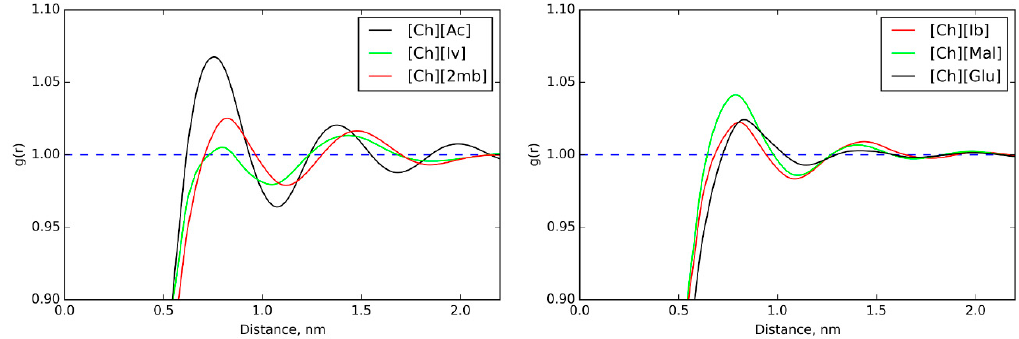
Figure 5. Cation ‒ cation radial distribution functions, g(r), calculated from the molecular dynamics trajectory data.